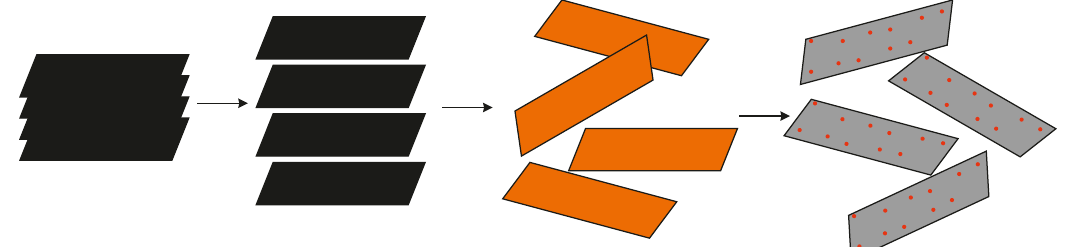
Figure 1: Common preparation methods of graphene/nanosilver